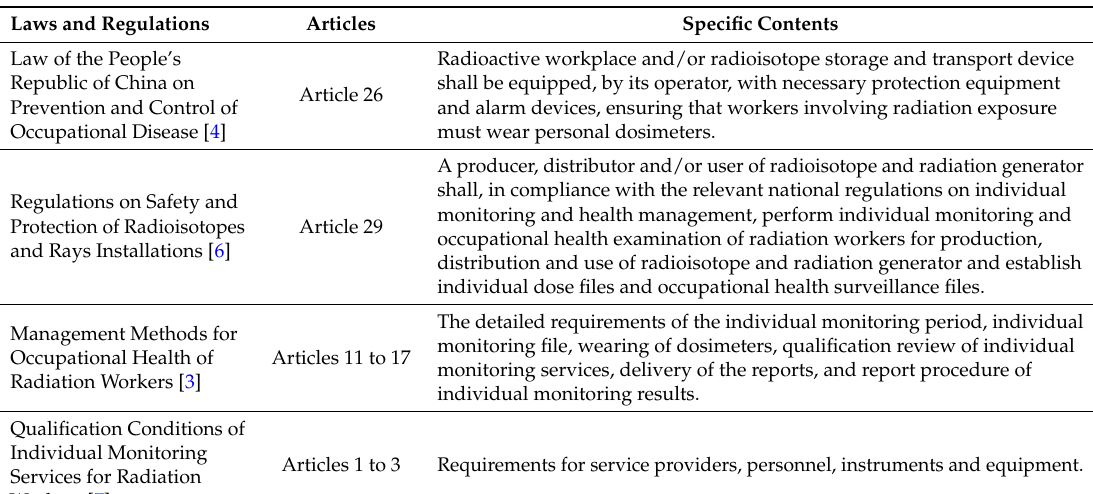
Table 1. Laws and regulations governing individual